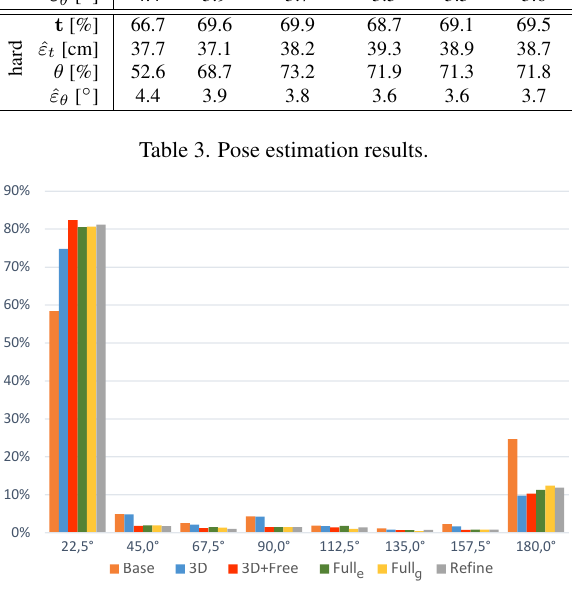
Figure 5. Histogram of absolute differences between estimated and reference orientations (correct detections of the easy